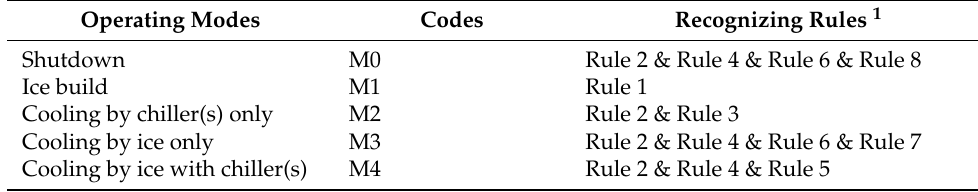
Table 2. Recognizing rules of system operating